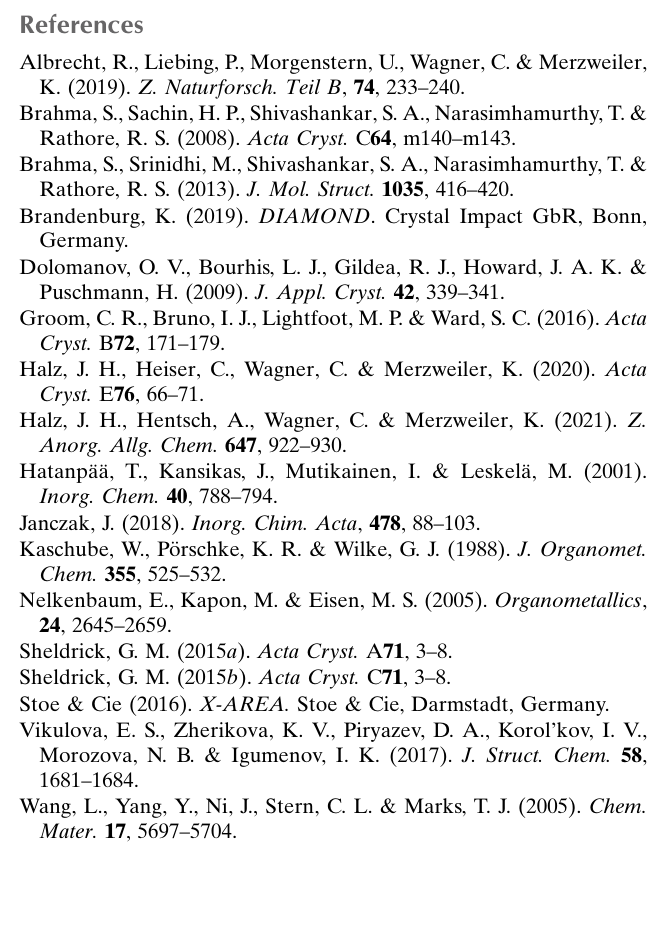
Data collection